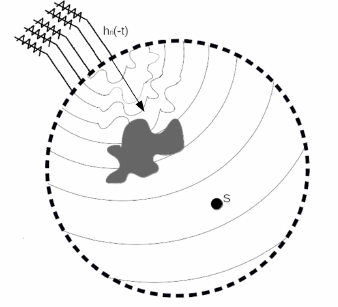
Figure 2. Backpropagation of h n ( t )